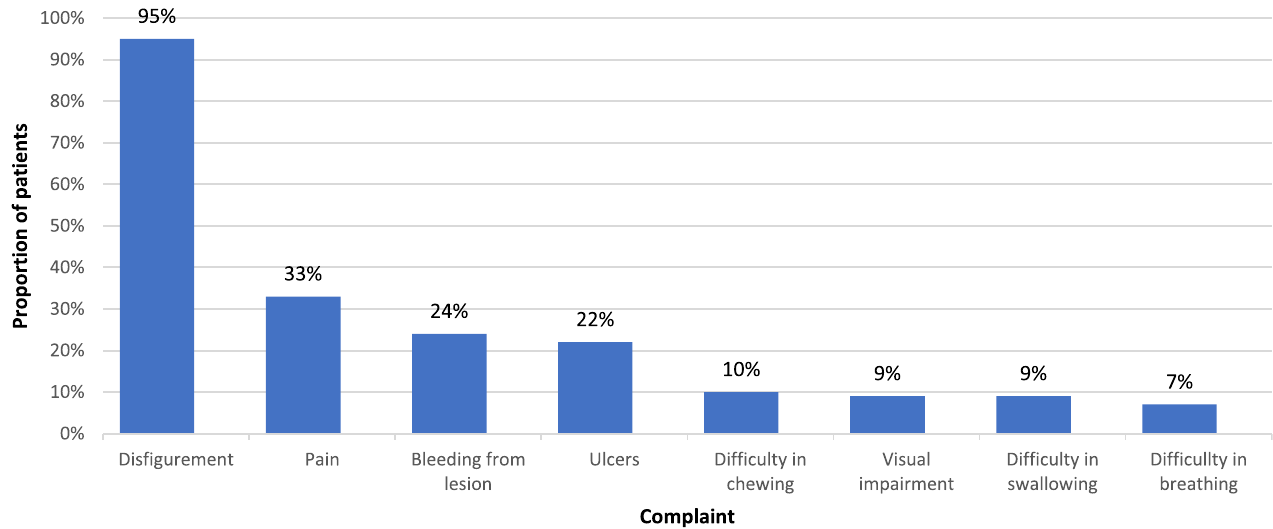
Fig. 2. Distribution of patients according to chief complaint.